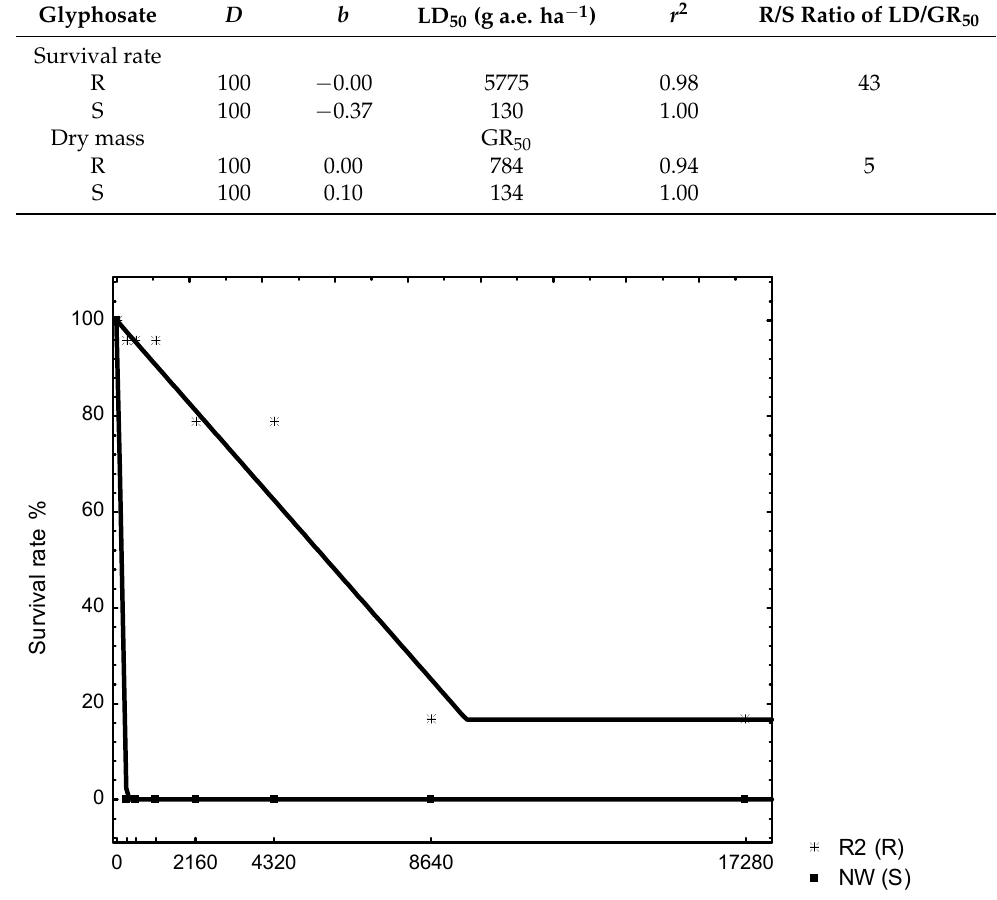
Table 2. Parameter estimates and associated model statistics for log–logistic response curves of resistant (R) and susceptible (S) plantago ( Plantago lanceolata L.) biotypes in response to glyphosate. Glyphosate D